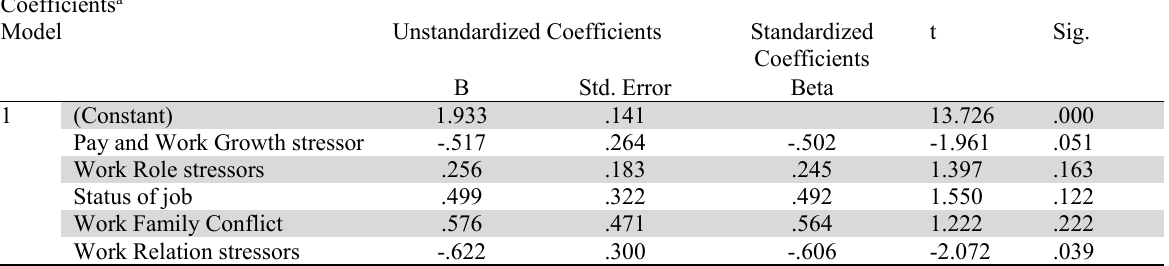
Regression coefficients for the impact of job stress on job satisfaction Coefficients a Model Unstandardized